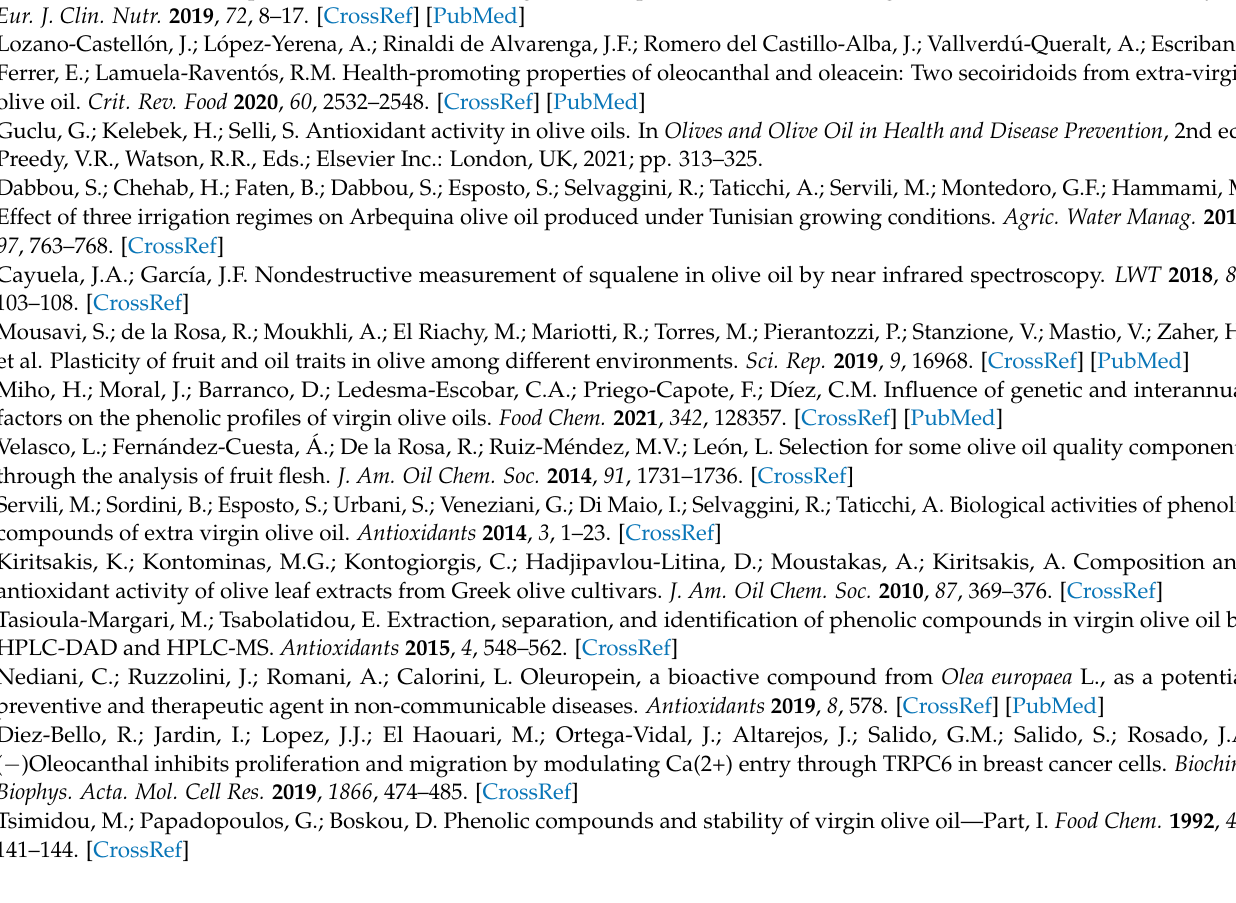
(%) in 61 cultivars and two consecutive crop seasons, Table S5: Descriptive statistics by analysis of the nineteen chemical parameters (expressed as mg kg − 1 of fresh fruit pulp) in 61 cultivars during two consecutive crop seasons, Table S6: Tests of between-subject effects from the general linear model for 61 olive cultivars in two consecutive crop